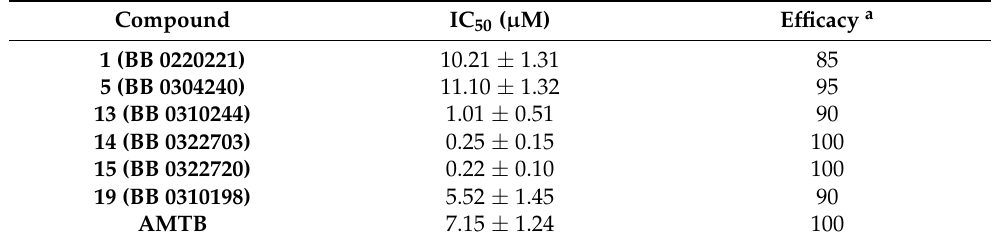
Table 2. IC 50s and efficacy for the selected compounds. Results are given as mean ± SD of at least three independent measurements .